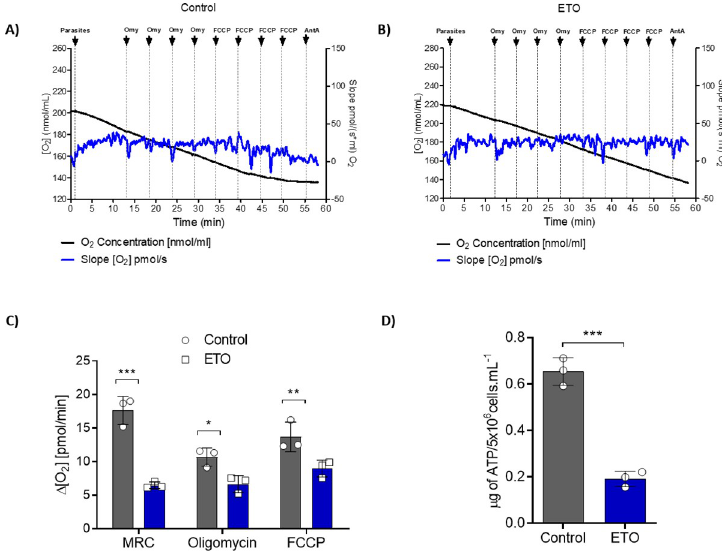
Fig 10. Effects of ETO on respiration and ATP production in epimastigote forms of T . cruzi . (A) Oxygen consumption of epimastigote forms after normal growth in LIT medium. (B) Oxygen consumption after ETO 500 μ M treatment. Parasite growth in LIT medium with the compound until the 5 th day. In black, a time-course register of the concentration (pmols) of O 2 in the respiration chamber. In blue, negative of the concentration derivative (pmols) of O 2 with respect to time (velocity of O 2 consumption in pmoles per second). The parasites were washed twice in PBS and kept in MRC buffer at 28˚C during the assays. (C) The basal respiration (initial oxygen flux values, MRC), respiration leak after the sequential addition of 0.5 μ g/mL of oligomycin A (2 μ g/mL), and electron transfer system (ETS) capacity after the sequential addition of 0.5 μ M FCCP (2 μ M) were measured for each condition. (D) Intracellular levels of ATP after treating with 500 μ M ETO. The intracellular ATP content was assessed following incubation with different energy substrates or not (PBS, negative control). The ATP concentration was determined by luciferase assay and the data were adjusted by the number of cells. All the experiments were performed in triplicates. Statistical analysis was performed with one-way ANOVA followed by Tukey’s post-test at p < 0.05 using GraphPad Prism 8.0.2 software. We represent the level of statistical significance as follows: ��� p value < 0.001; �� p value < 0.01; and � p value < 0.05. For p values > 0.05, we consider the differences not significant